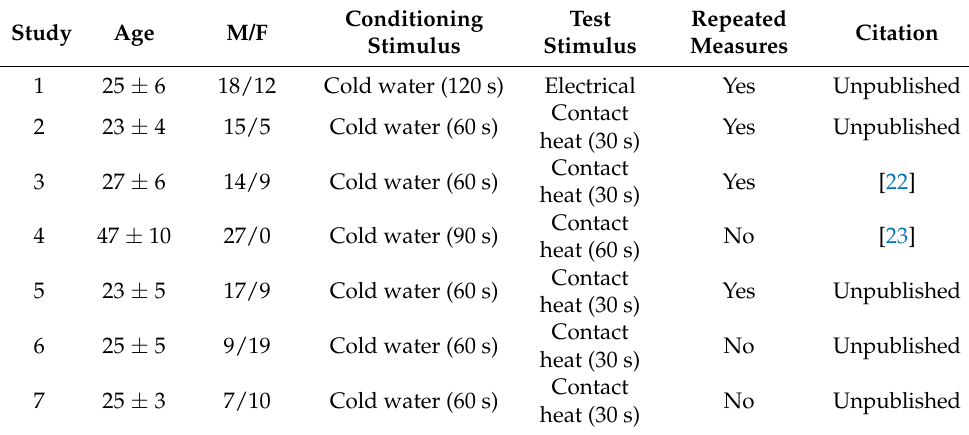
Table 1. Overview of studies used for pooled data in this analysis. N = 171 participants total. Repeated measures: n = 97 participants, n = 208